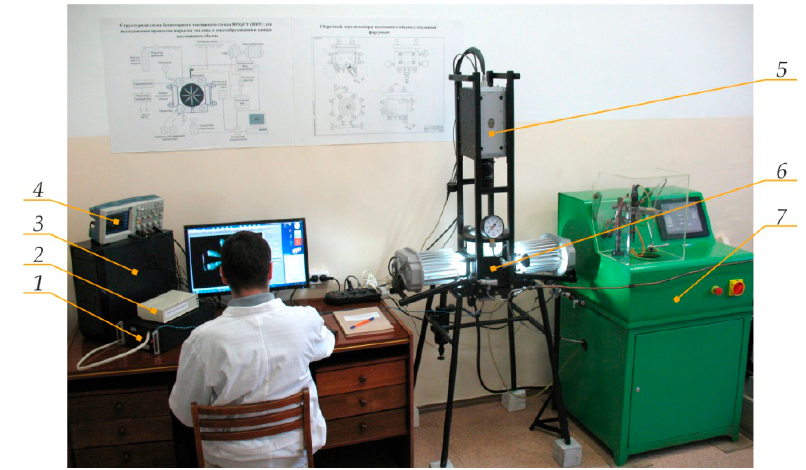
Figure 7. Photograph of the experimental setup for studying injection and mixing processes in a constant volume chamber with high-speed camera: 1—Electronic control unit; 2—controller-synchronizer; 3—personal computer; 4—oscilloscope; 5—high-speed camera; 6—constant volume chamber with LED lights; 7—stand for testing fuel equipment of Common Rail type.